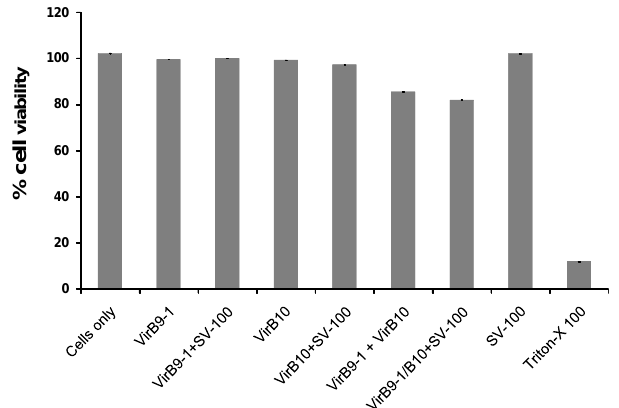
Figure 4. Cytotoxicity of the VirB9-1 and VirB10 in PBS, adsorbed to SV-100, combination of VirB9-1 and VirB10 with or without SV-100 were evaluated using the 3-(4,5-dimethylthiazol-2-yl)-2,5- diphenyltetrazolium bromide (MTT) assay at 10 μg/mL. Error bars indicate standard deviation. 2.4. VirB9-1 and VirB10 Stimulate Specific Proliferation of Bovine T-Lymphocytes